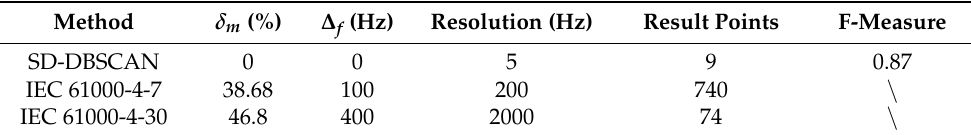
Table 4. Results of the synthetic signal processed by the proposed method, IEC 61000-4-7, and IEC